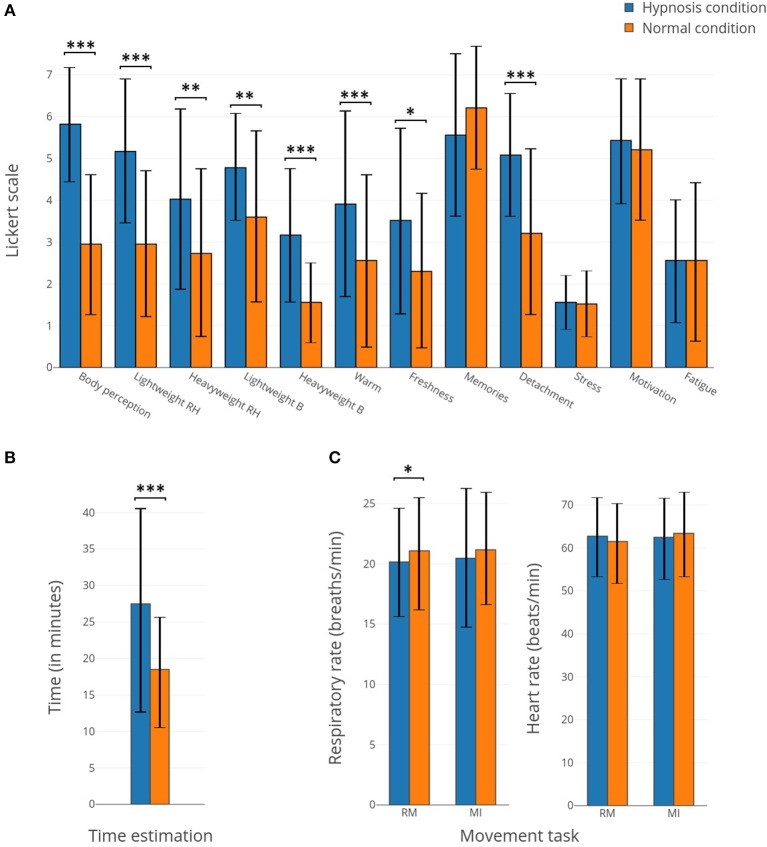
(A) Bar plots representing the responses to the questionnaires concerning the 12 items related to the subject's perceptions for hypnotic (in blue) and normal (in orange) conditions. (B) Bar plots representing the time estimation for hypnotic (in blue) and normal (in orange) conditions. (C) Bar plots representing the respiratory rate and heart rate for hypnotic (in blue) and normal (in orange) conditions. *Corresponds to a p-value <0.05, **corresponds to a p-value <0.01 and ***corresponds to a p-value <0.001.